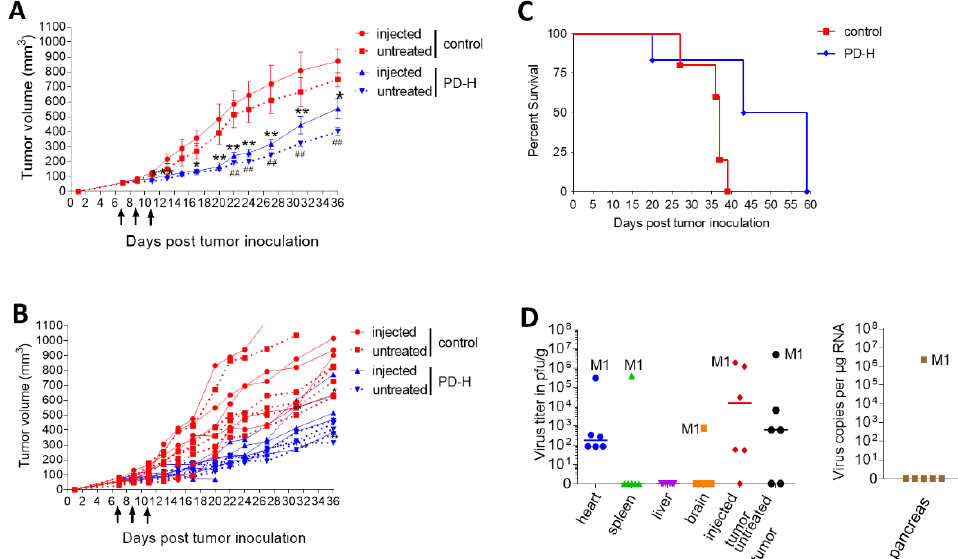
Figure 3. Oncolytic activity and safety of PD-H in nude mice with DLD-1 cell tumors. DLD-1 cell tumors were established on both flanks of Balb/C nude mice. When the tumor size reached ~0.5 cm diameter, one of the tumors was injected with 3 × 10 6 pfu PD-H ( n = 6) or PBS (control, n = 5), while the contralateral tumor remained untreated. Two and four days after injection, the same tumor was reinjected using each 3 × 10 6 pfu of PD-H. ( A ) Tumor growth. The data are shown as mean values ± SEM for each group. Injected means the tumor which was injected with PBS (control) or with PD-H; untreated means the contralateral tumor of the same animal which was not injected. Significance between control vs. PD-H group: injected tumor * p < 0.05; ** p < 0.01; untreated tumor ## p < 0.01 ( B ) Tumor growth. Data of A shown for each animal. ( C ) Kaplan − Meier survival curve. Significance between control and PD-H-treated mice; p = 0.0179. ( D ) Biodistribution of PD-H. Organ samples from mice were collected on the day when the animals were sacrificed. M1 represents data points of mouse #M1, which was sacrificed on day 13 after tumor cell administration because of signs of virus-induced sickness and pronounced loss of body weight. Left diagram: PD-H titers determined by plaque assay in indicated organs and in the injected and untreated contralateral tumors. Right diagram: Virus genome copy number in the pancreas as determined by qRT-PCR. Note: pancreatic tissue enzymes make it impossible to perform proper analysis of virus titer using plaque assays as pancreatic tissue lysate causes cytotoxicity in HeLa cells, which we used for the plaque assays. Therefore, we always perform quantitative RT-PCR to measure presence of viral RNA in pancreatic tissue. Data are shown as medians for each group and for each